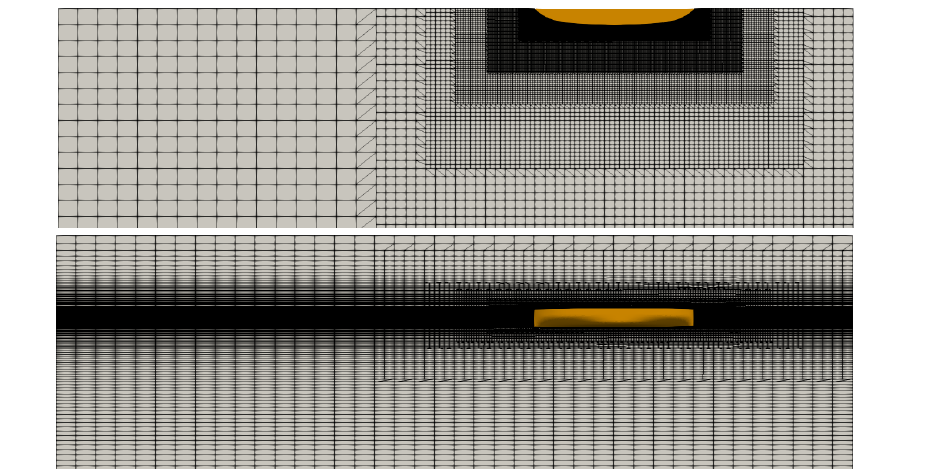
Figure 3. Top and side view of the mesh for the computational domain. Upper one: top view; lower one: side